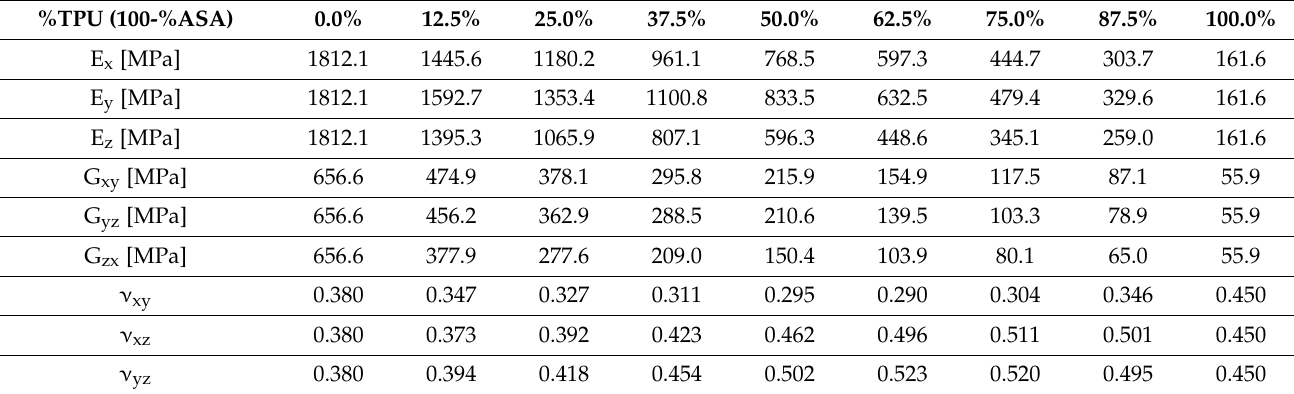
Table 6. Coefficients of the stiffness matrix, depending on the material fraction, obtained by homoge- nization of the ASA-TPU